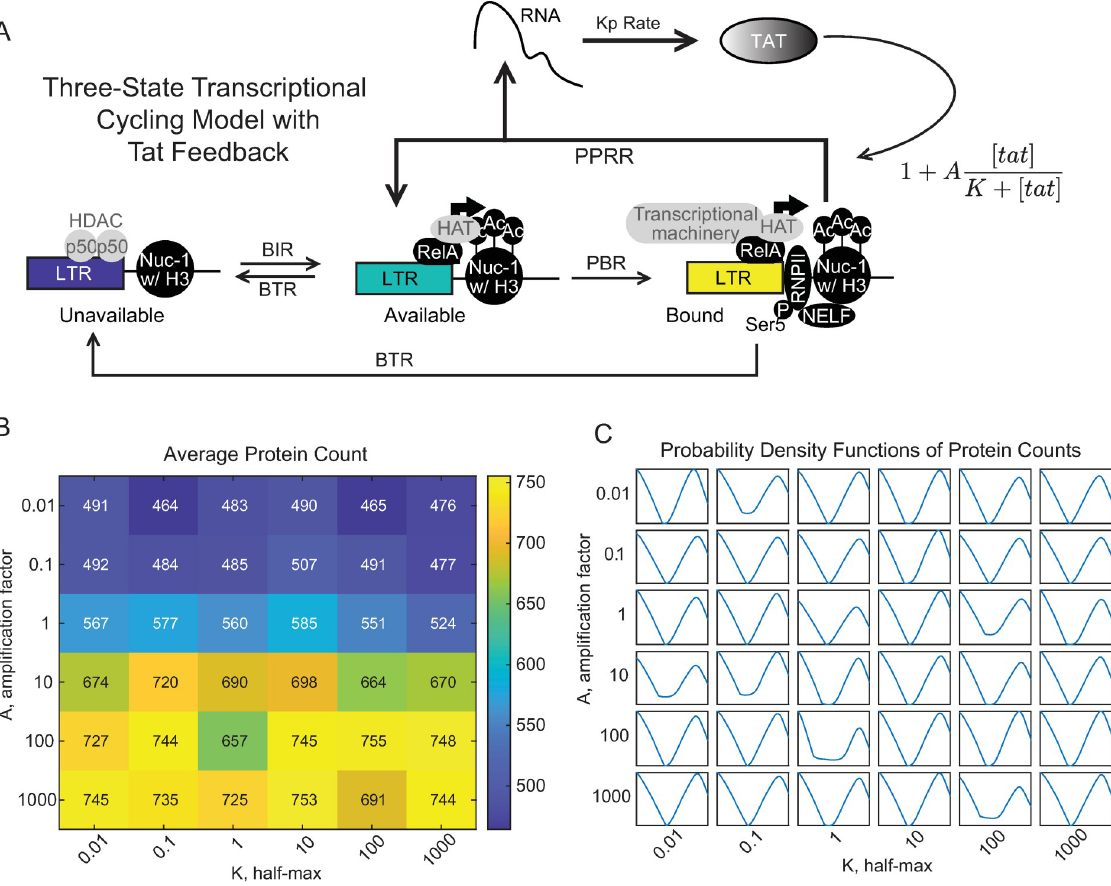
Fig 3. Positive feedback on PPRR activation does not influence bimodality of the mRNA and protein distributions in the three-state transcriptional cycling model. (A) Updated three-state promoter system with HIV nucleosome remodeling, RelA recruitment, and Tat- mediated transcript elongation, which is amplified via positive feedback. Positive feedback is modeled as a saturating function with an amplitude, A, and half-max, K. (B) Heatmap of average protein counts at 24 hours with feedback. Protein counts were generated through stochastic simulation for 1,000 cells for each combination of K and A, which were varied over 5 orders of magnitude. The other parameters were fixed as follows: BIR = 0.1 hr -1 , BTR = 1 hr -1 , PBR = PPRR = 10 hr -1 (C) Kernel fittings of mRNA counts at 24 hours. Each box contains the probability density curve for that parameter